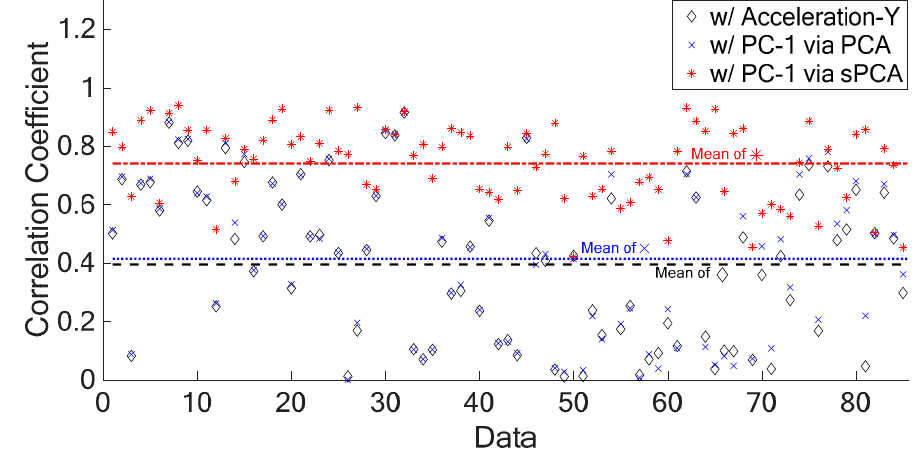
Figure 10. Correlation coe ffi cient: COP-AP signal versus acceleration signal in the Y-axis (black ♦ ); COP-AP signal versus PC-1 of acceleration signals with principal component analysis (PCA) for the whole data length (blue × ); COP-AP signal versus PC-1 of acceleration signals via segmentalized PCA (sPCA) (red *); mean value of ♦ (black —); mean value of × (blue ...); mean value of * (red -.-.-).